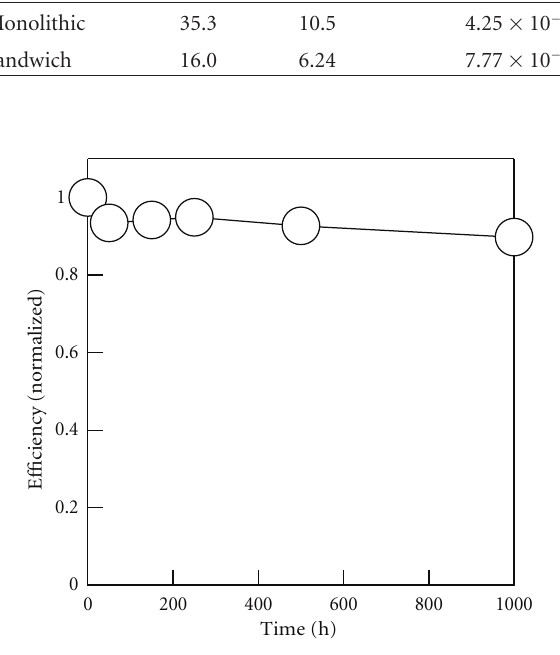
Figure 8: Stability test of monolithic DSC using ionic liquid elec- trolyte at 80 ◦ C in the